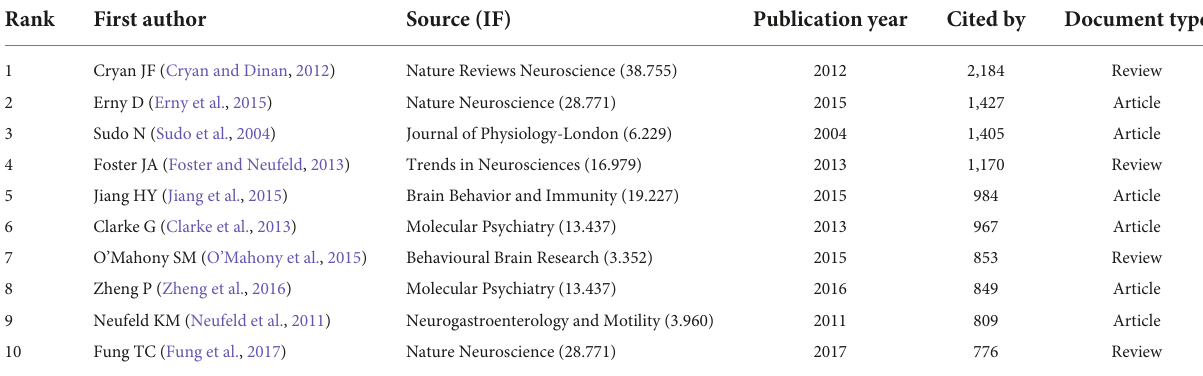
TABLE 5 Top 10 highly cited publications on research in gastrointestinal microbiome and neuroscience.